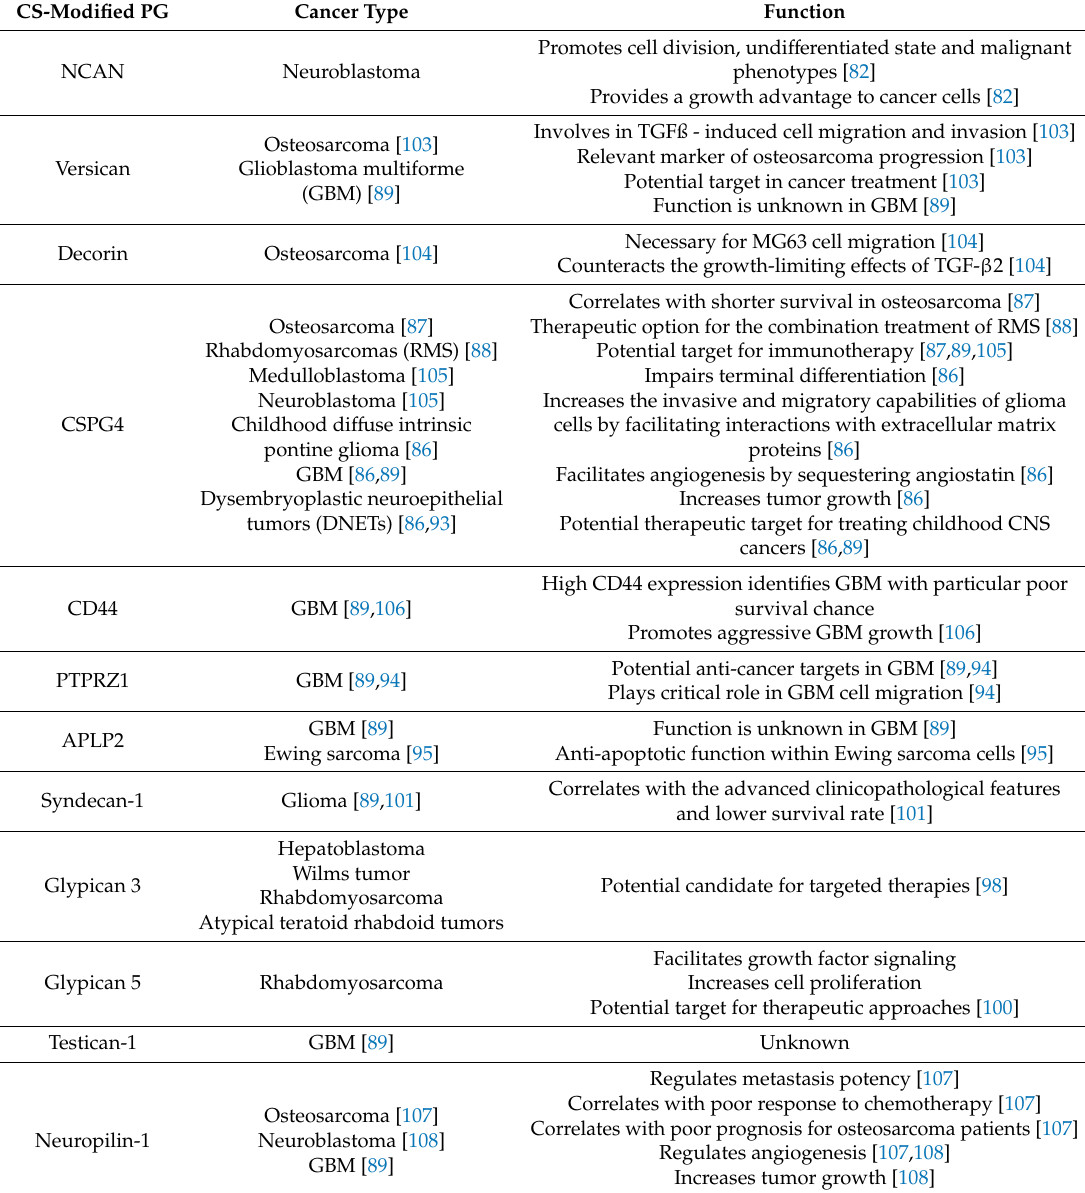
Table 1. Chondroitin sulfate proteoglycan (CSPG) expression in childhood solid